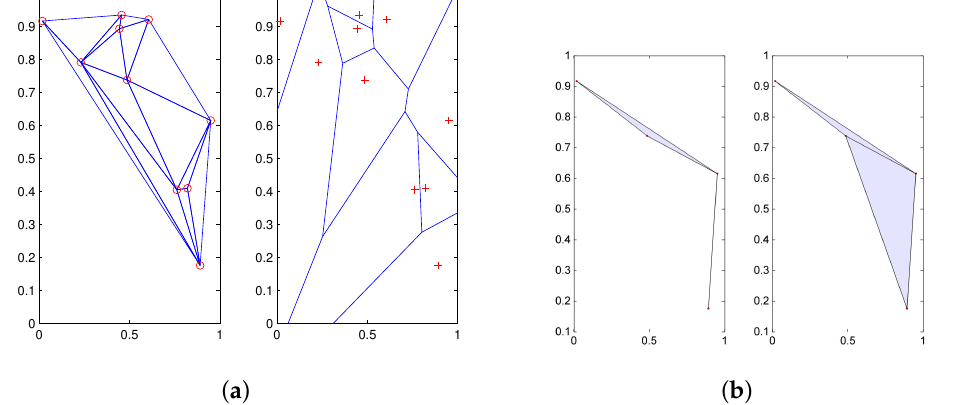
Figure 2. ( a ) a Delaunay triangulation of a collection of points in the plane with the corresponding Voronoi diagram, and ( b ) two associated witness